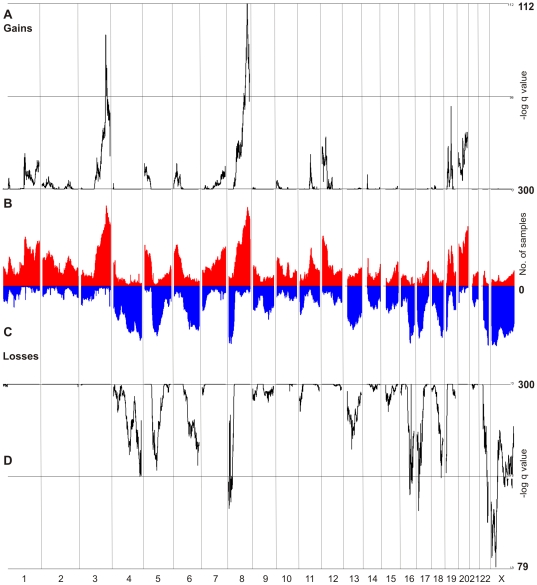
CNA in ovarian cancer.Gains (A) and losses (D) in 240 samples on SNP6 arrays analysed by GISTIC. Gains (B) and losses (C) in 398 samples on various array platforms. Sample segments were overlapped in Partek Genomics Suite v 6.4, creating a data point for each segment defined by copy number breakpoints, and then plotted by sample number.